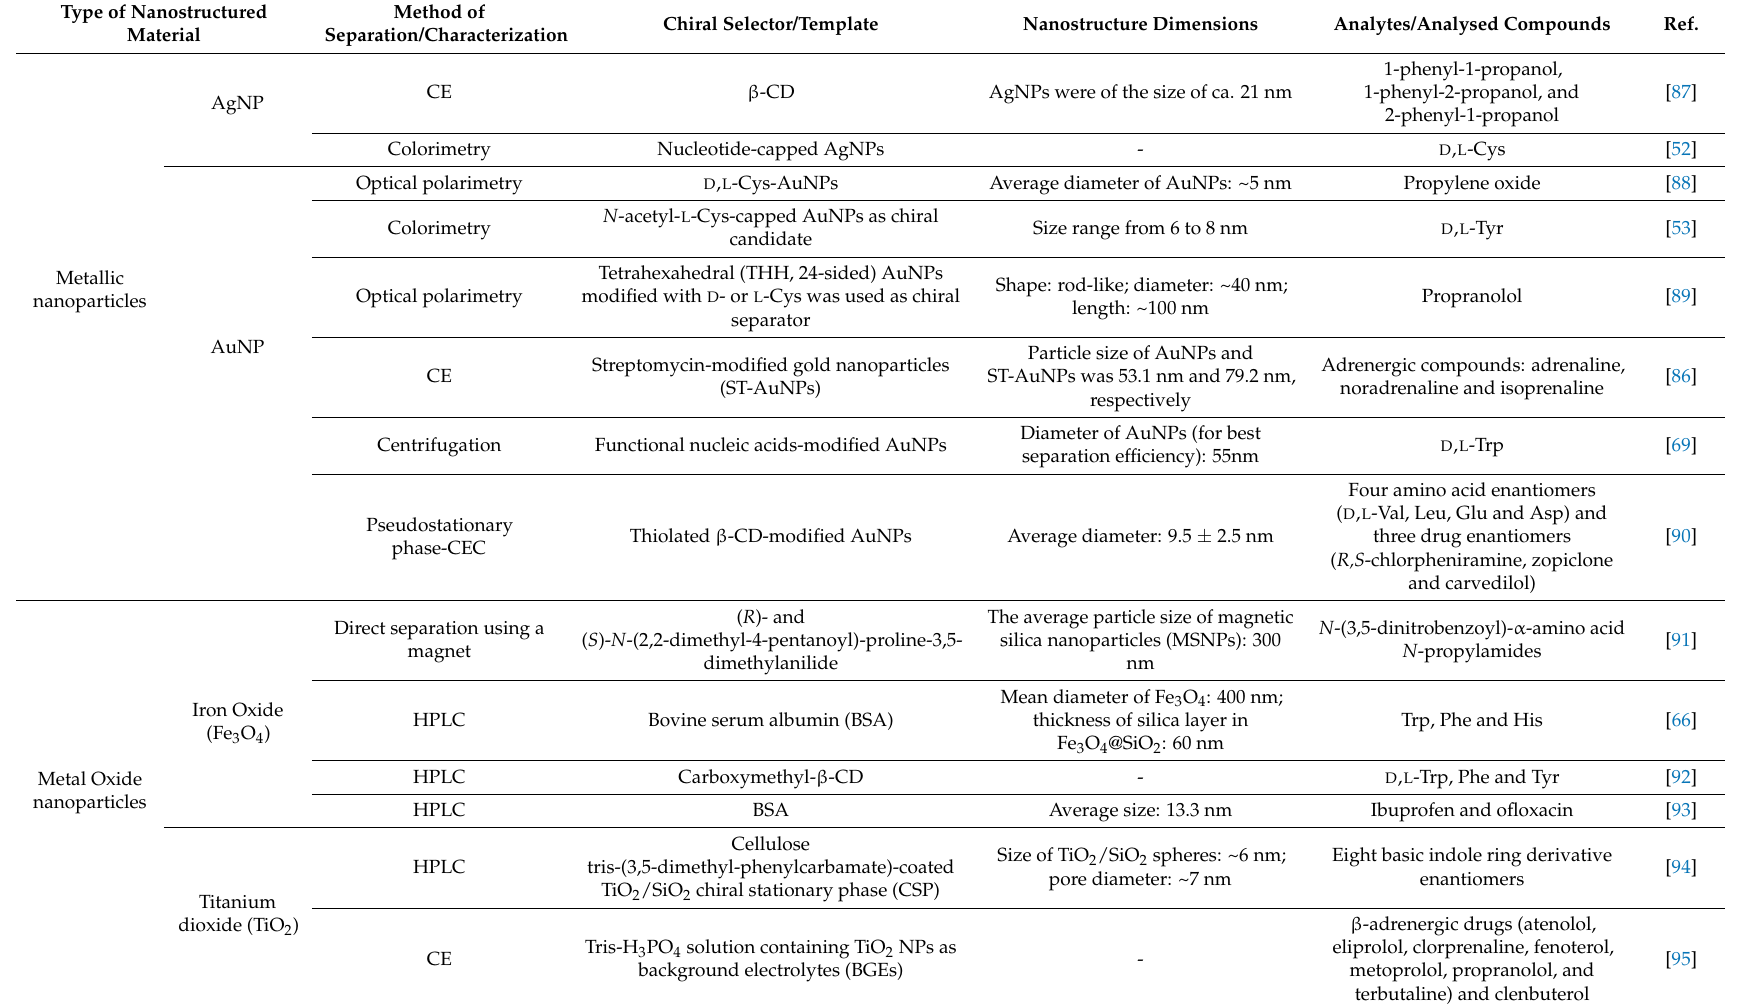
Table 2. Some representative examples in which nanomaterials have been used for the separation of chiral compounds